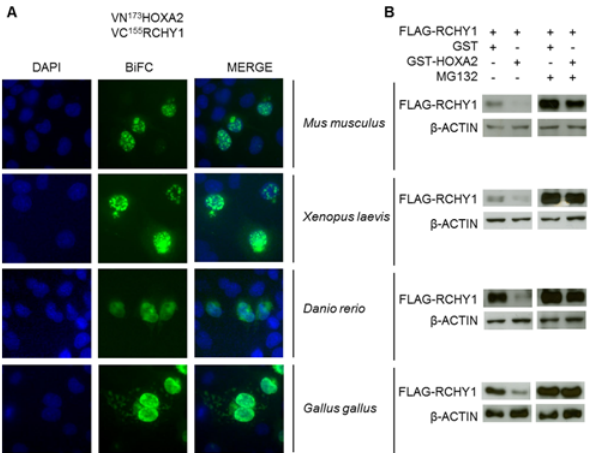
Fig 3. The RCHY1-HOXA2 interaction and HOXA2-induced degradation of RCHY1 are evolutionarily conserved processes. (A) COS-7 cells were transfected with different combinations of vectors coding for VN 173 HOXA2 and VC 155 RCHY1 originating from different vertebrate species and treated with the MG132 proteasome inhibitor for 6 h. Nuclei were stained with DAPI (blue). (B) HEK293T cells were cotransfected with different combinations of expression vectors coding for FLAG-RCHY1 and GST or GST-HOXA2 from different vertebrate species and treated or not with the MG132 proteasome inhibitor. Cell lysates were then subjected to immunoblot analysis with antibodies recognizing FLAG and β